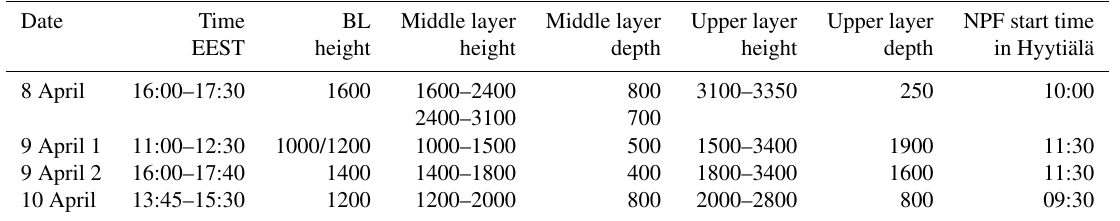
Table 1. Case study I: flight times, diagnosed layer parameters (boundary, middle and upper layers height and depth in metres) and new particle formation (NPF) start